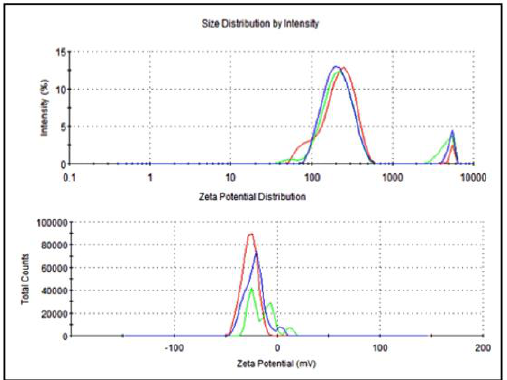
Figure 3. Particle size and zeta potential distribution of nanoemulsified vit-C by intensity using dynamic light scattering correlation spectroscopy. The average particle size of nanoemulsified vit-C was around 225.4 nm, and the zeta potential of nanoemulsified vit-C was around − 21.3 mV. The PDI value of the nanoemulsified vitamin C was 0.81.